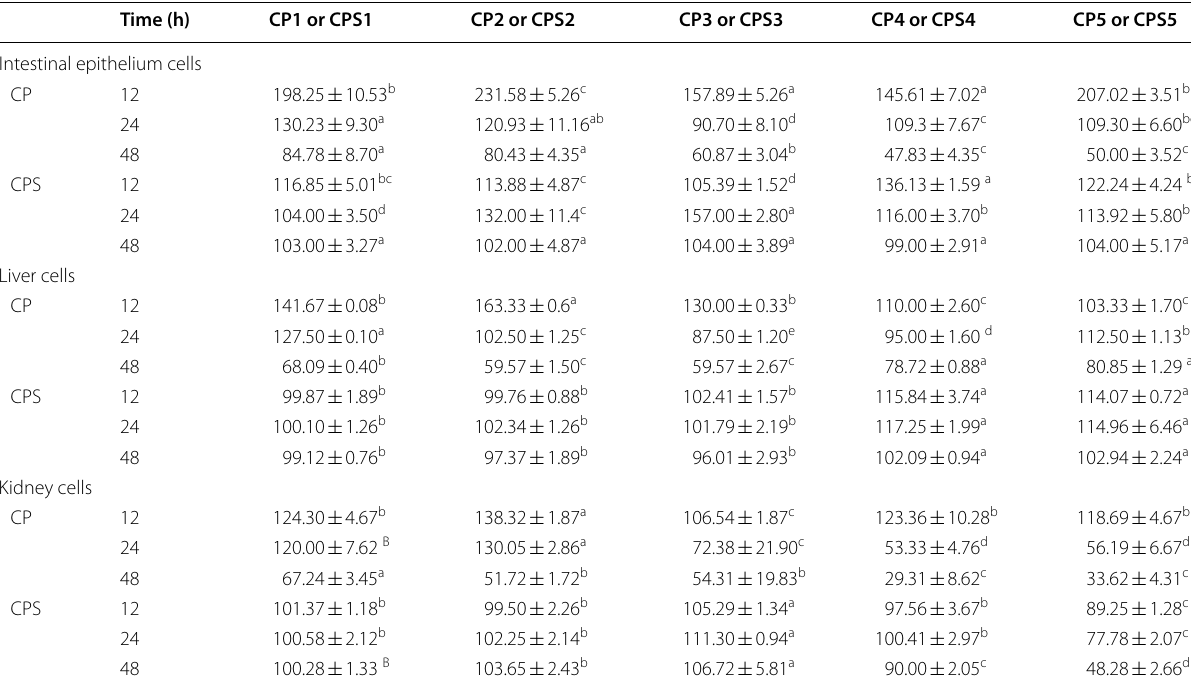
Table 4 Effects of different CP or CPS concentrations and incubation time on primary cell viabilities (%)